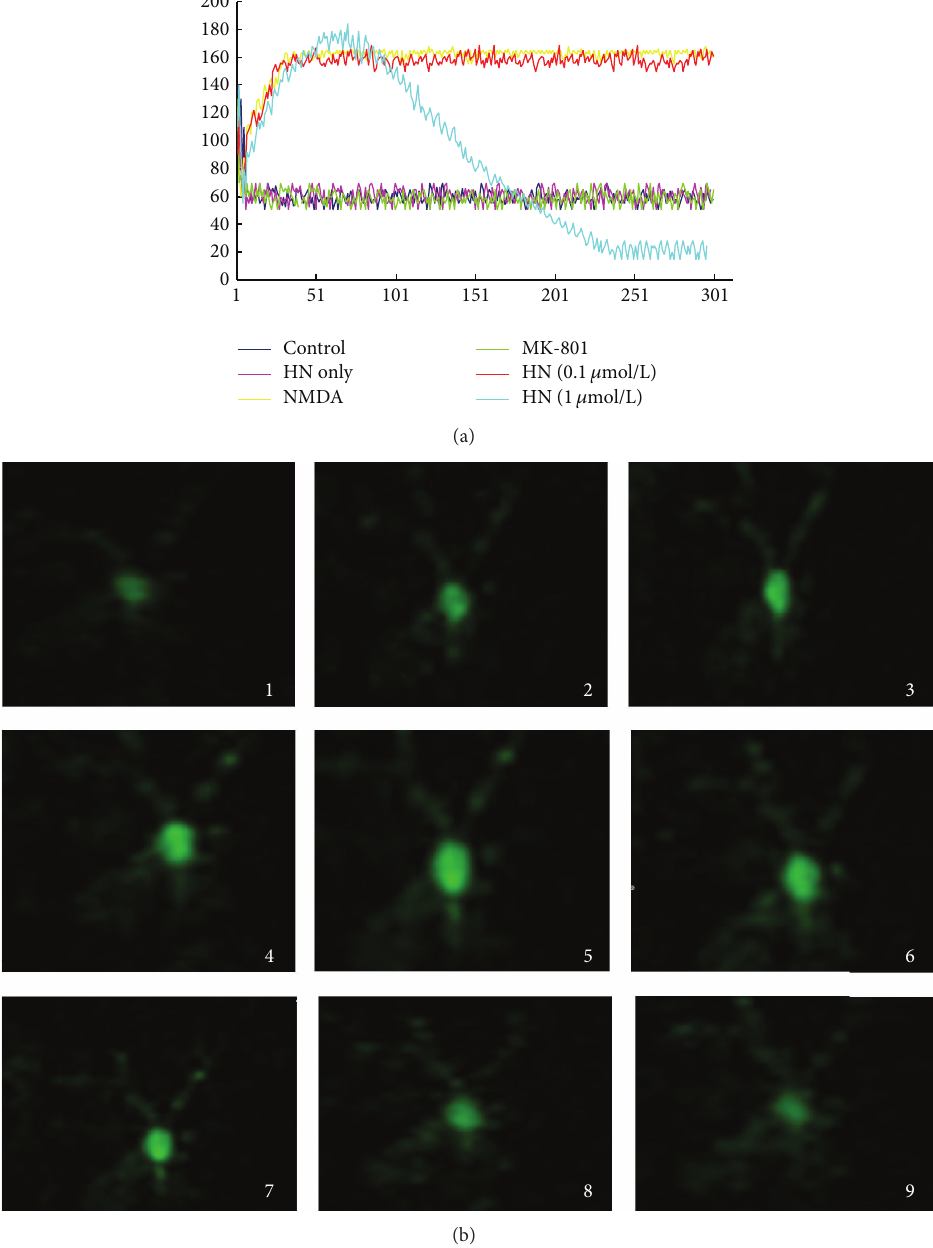
Figure 5: (a) Effect of humanin on NMDA triggered dynamic changes of cytoplasmic Ca 2+ concentration. The fluorescence intensity which is related to cytoplasmic Ca 2+ concentration was captured and recorded every 660 ms for 300 successive measurements (for about 198 s) for each subject. 5 to 10 neurons were measured in every group. The curves are formed by the connection of 300 data which stand for the average instantaneous fluorescence intensity of each group. HN only: the addition of 10 𝜇 M HN itself in the medium. HN (0.1 𝜇 mol/L) and HN (1 𝜇 mol/L) groups: HN (0.1 𝜇 mol/L) or HN (1 𝜇 mol/L) in NMDA treatment groups. (b) Effect of humanin on NMDA triggered dynamic changes of cytoplasmic Ca 2+ concentration. Picture 1 to picture 9 stand for the typical successive cellular morphological characteristics of HN (1 𝜇 mol/L) on NMDA-triggered increase of cytoplasmic Ca 2+